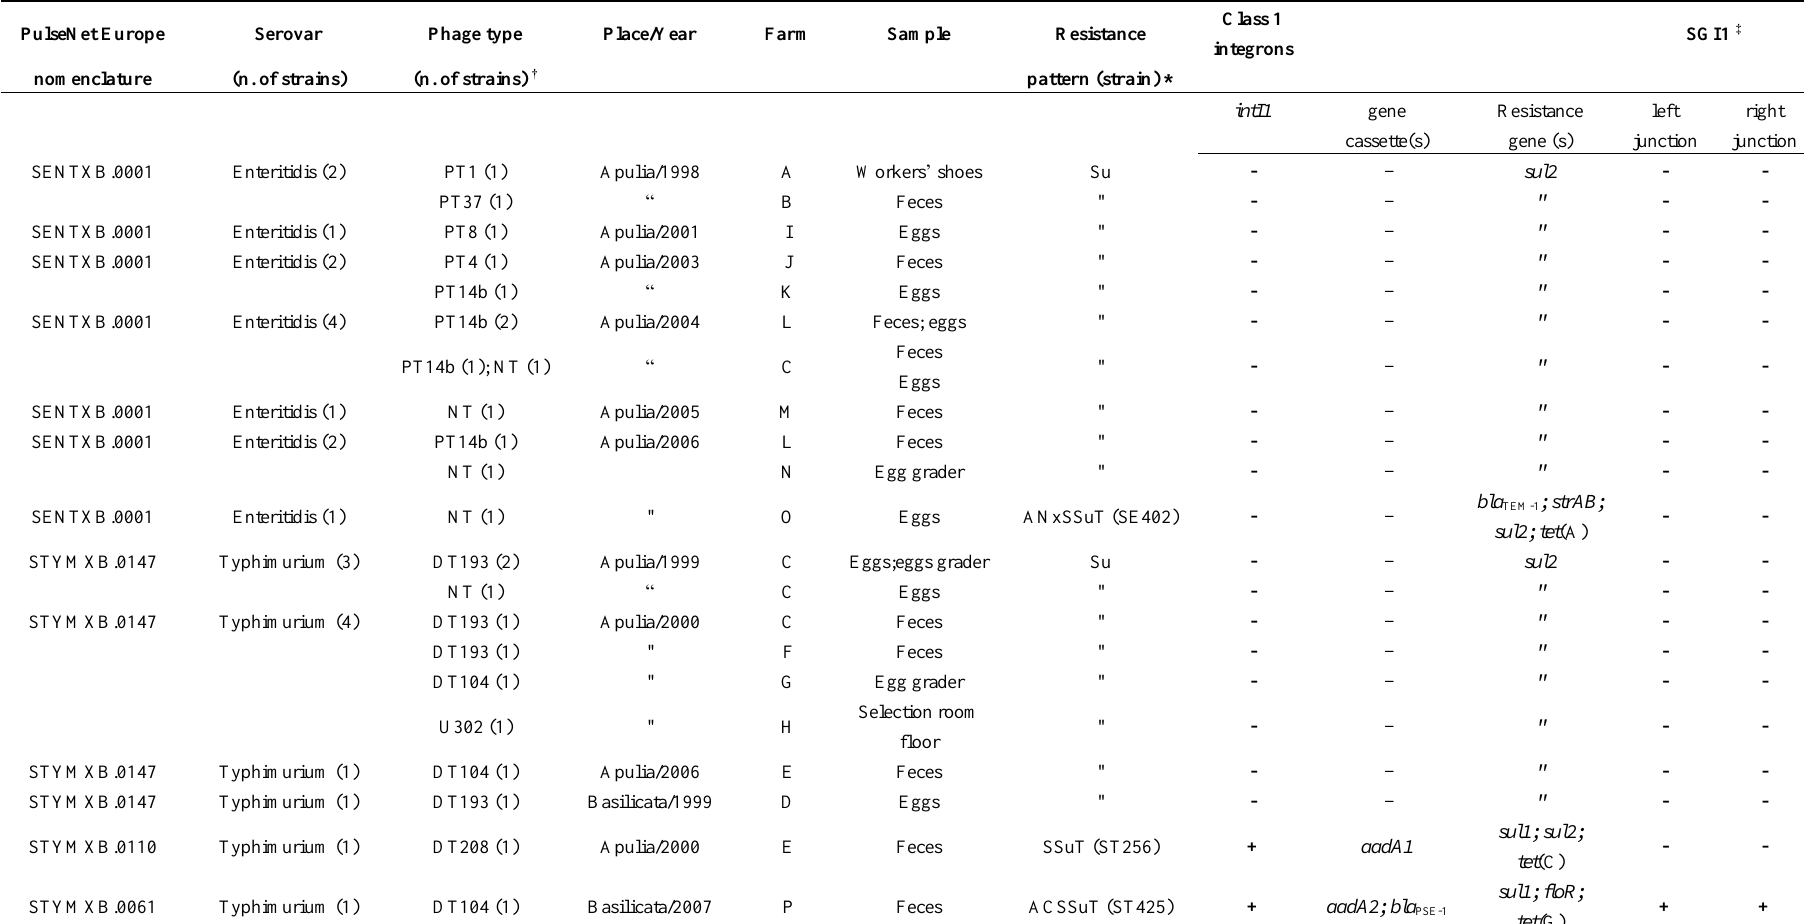
Table 1. Antimicrobial susceptibility, phage types, pulsotypes, PCR detection of SGI1, class 1 integrons and resistance genes in S. enterica strains isolated from laying hen farms in Italy in